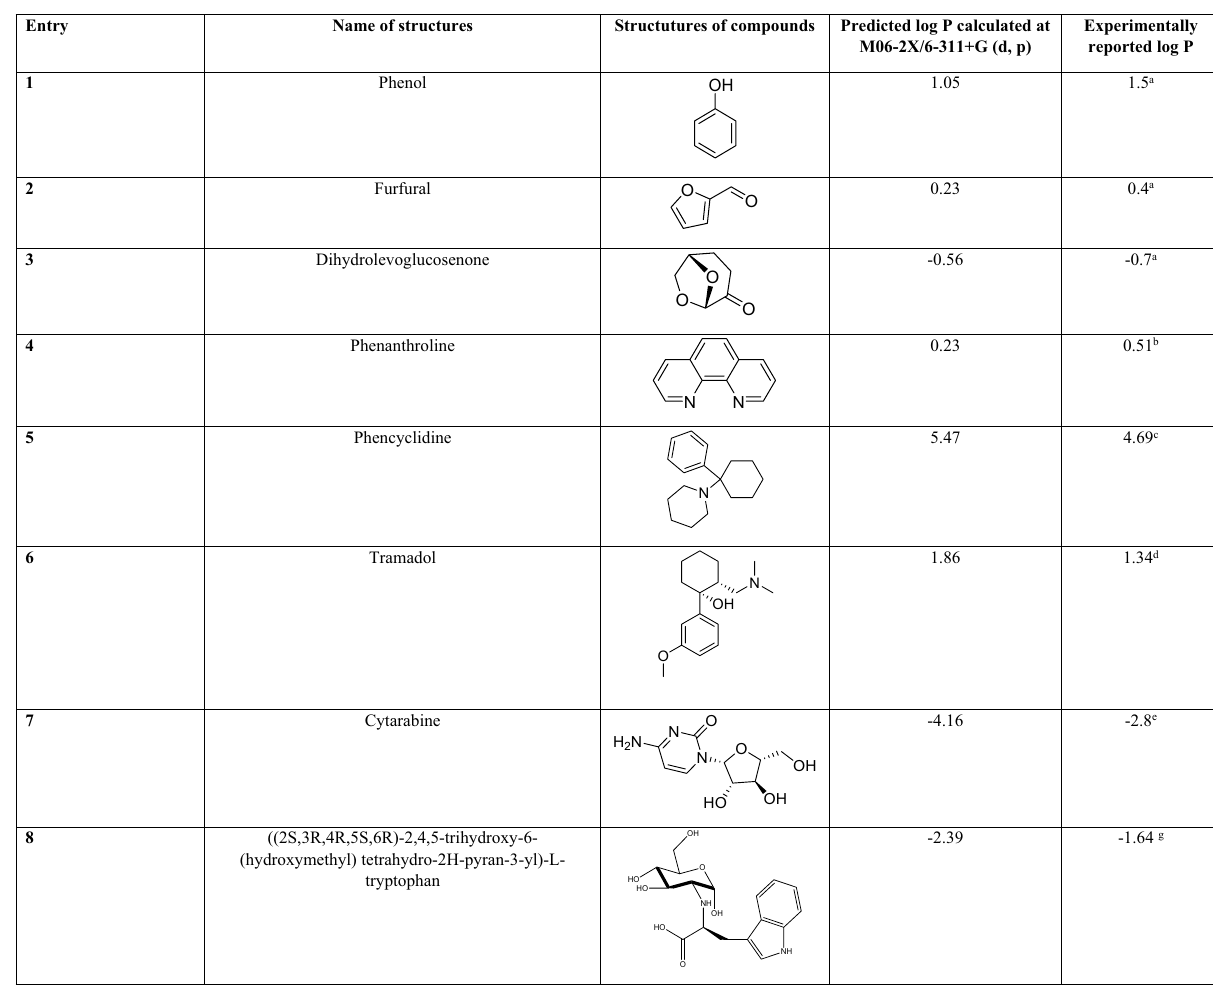
Table 2. The calculated (at the M06-2X/6 ‐ 311+G (d, p) level) and experimental log P values. References for